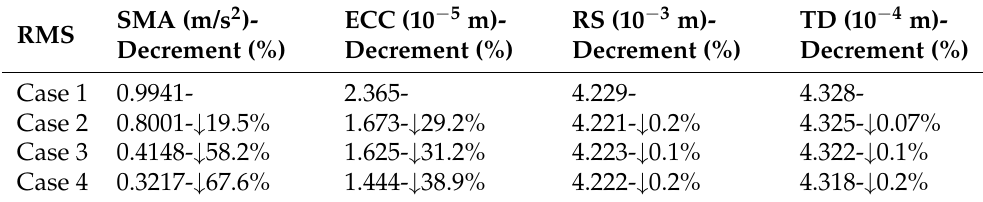
Table 2. Root Mean Square (RMS) optimization results.